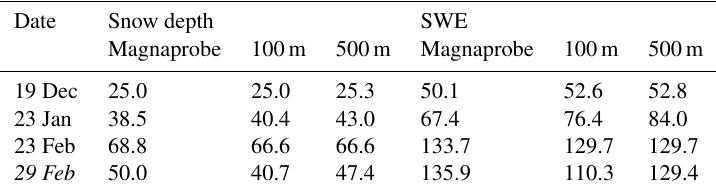
Table 6. The proportionally weighted averages of snow depth (cm) and SWE (mm) for the 7km × 10km land areas in the Sodankylä and the Saariselkä test sites (italic) for the three different cases of measurement